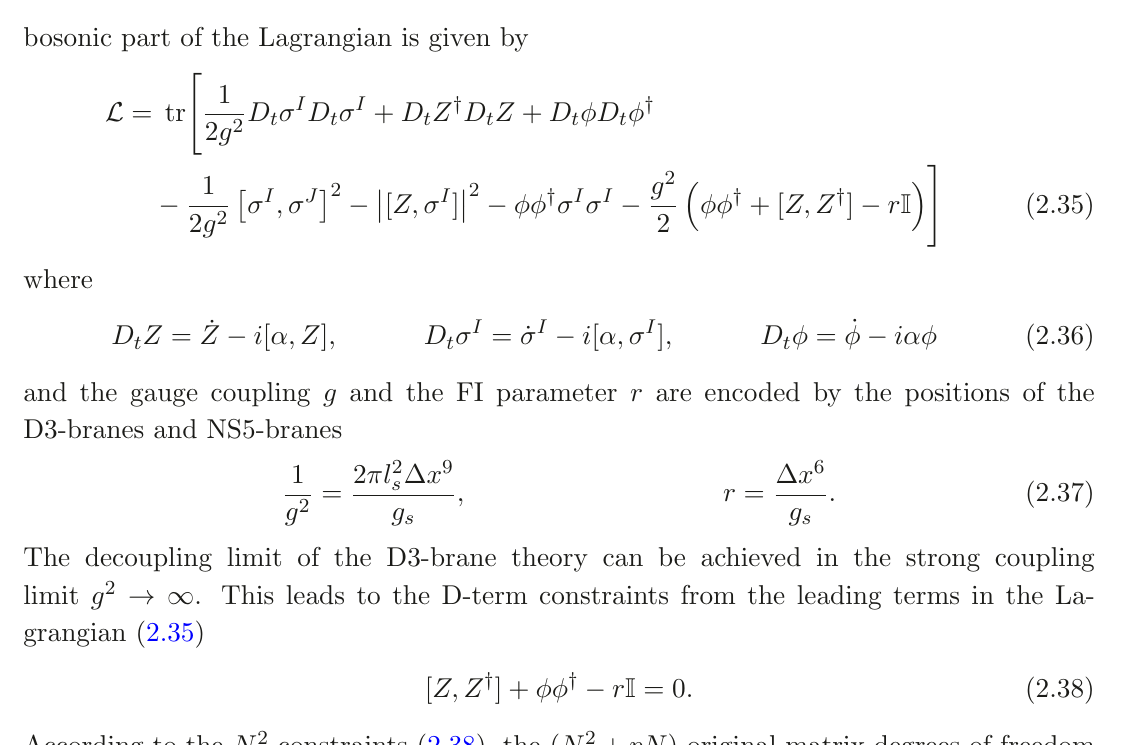
= 4 U( p ) Yang-Mills-Higgs theory on p N